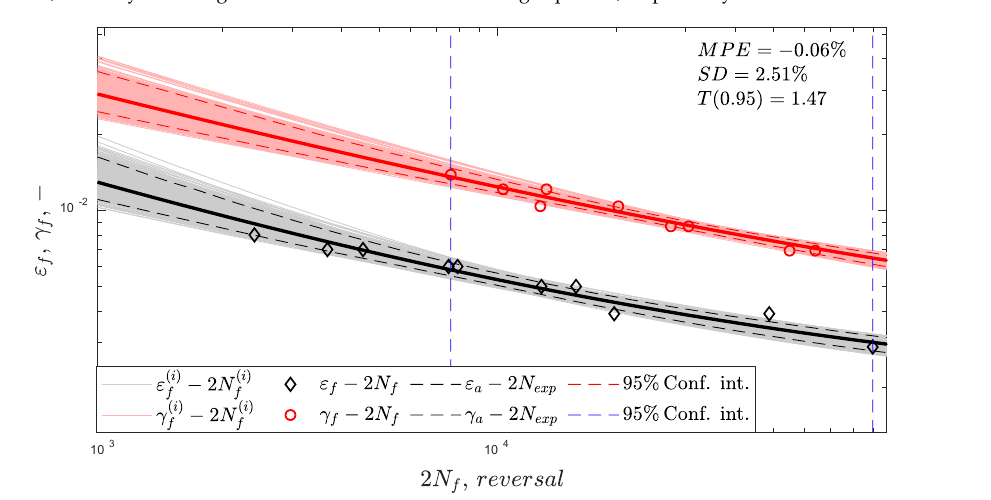
Figure 1. Shear and axial strain-life fatigue curves for CuZn37 with error indexes MPE , SD , T ( 0.95 ) (described in Section 4.1).